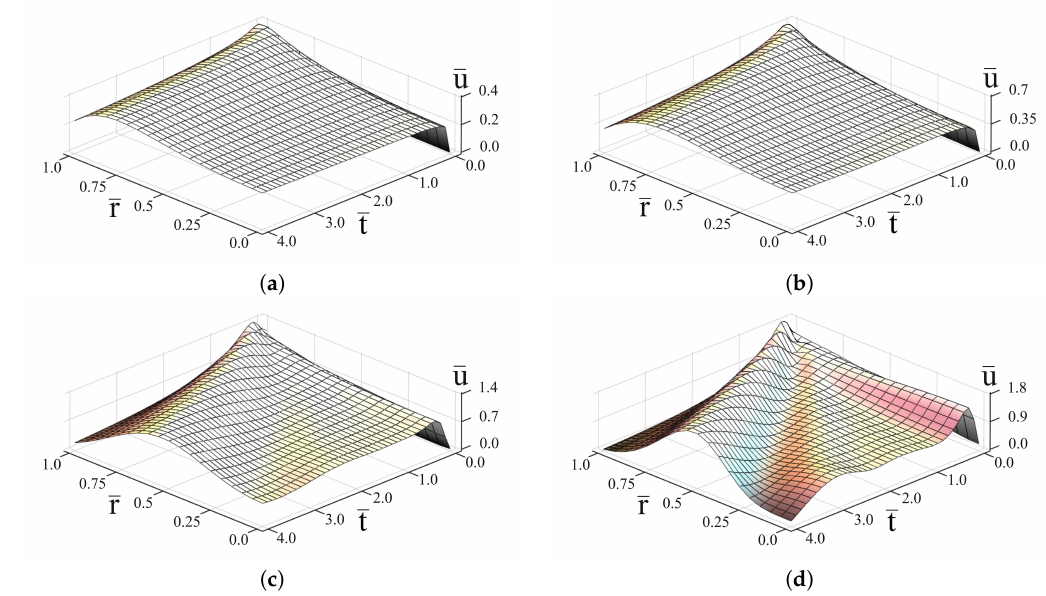
Figure 1. Evolution of the solution for the problems (12)–(15) under constant impact. The results of computer simulation of the formula (27) for the parameters ¯ b = 4, ¯ ω = 0 and different values of α : α = 0.5—( a ); α = 0.75—( b ); α = 1.25—( c ); α = 1.5—( d ).